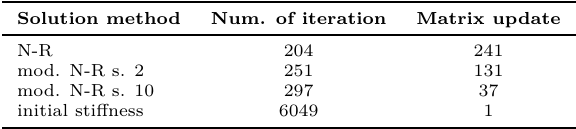
Table 1. Number of iterations for different